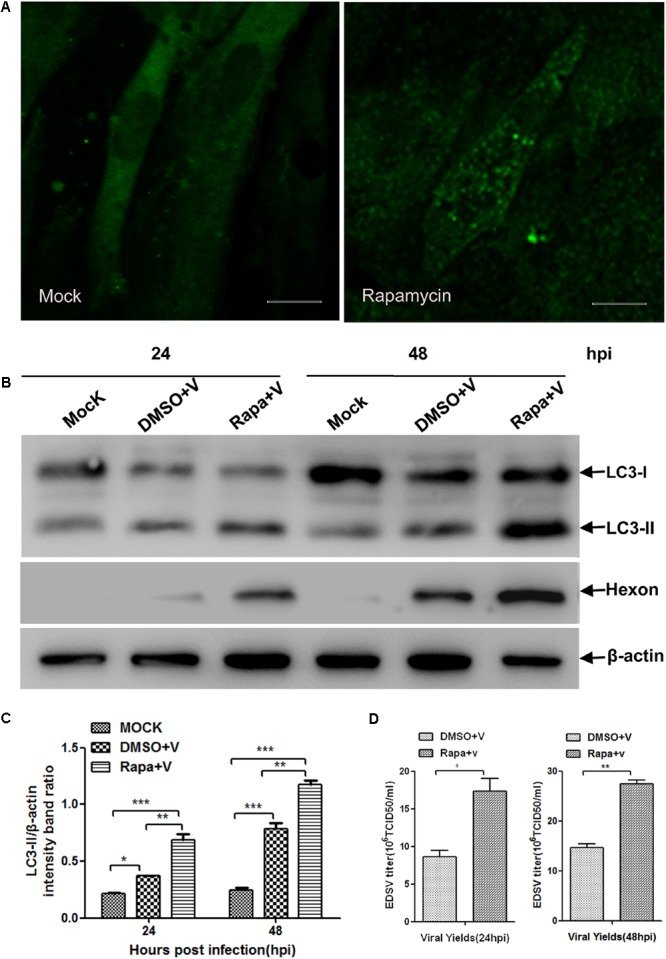
Autophagy induction enhanced the replication of EDSV. (A) A representative image from confocal immunofluorescence microscopy analysis of LC3 expression in EDSV-infected DEFs or DEFs treated with 100 nM rapamycin prior to EDSV infection. Scale bar = 10 μm. (B) Western blot analyses the cells infected with DMSO (mock), cells treated with rapamycin for 4 h and then infected with EDSV at an MOI of 1 (Rapa + v), cells treated with DMSO for 4 h and then infected with EDSV at an MOI of 1 (DMSO + v), which were harvested at 24 and 48 hpi. (C) Densitometric analysis of both LC3-ll and β-actin proteins in mock, Rapa + v, and DMSO + v groups. (D) Quantification of the yields of virus progeny in EDSV-infected DEFs pretreated with DMSO (DMSO+V) and in EDSV-infected cells pretreated with rapamycin (Rapa+v) were determined according to the TCID50/mL. The results are shown as the mean ± SEM (n = 3). ∗P < 0.05; ∗∗P < 0.01; ∗∗∗P < 0.001.